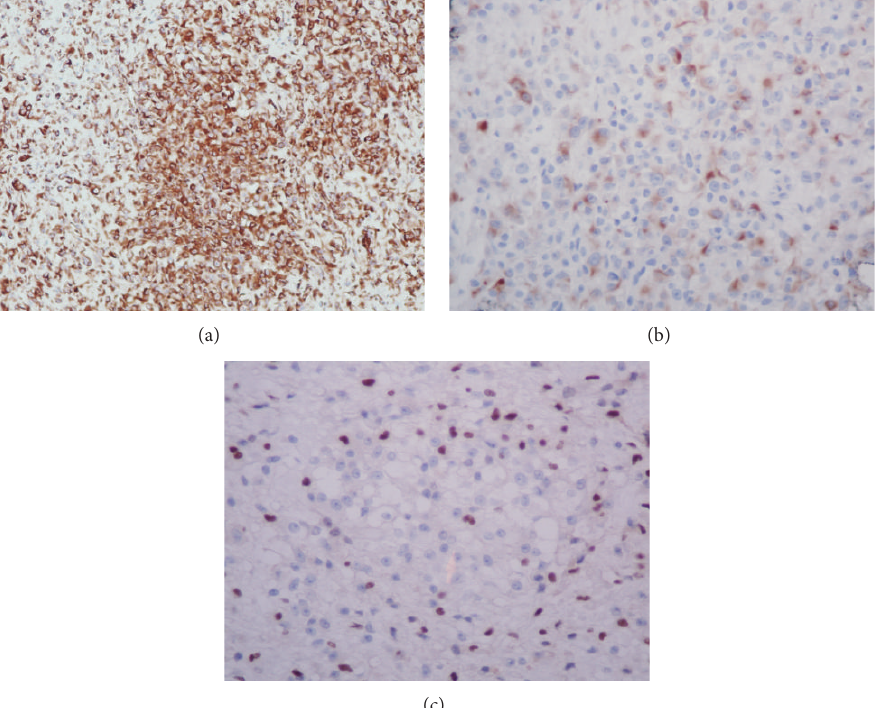
Figure 4: IHQ analysis. (a) The tumor cells presented diffuse positivity staining for vimentin and (b) focal positive staining for AE1/AE3. (c) The tumor cells showed loss of INI-1 protein